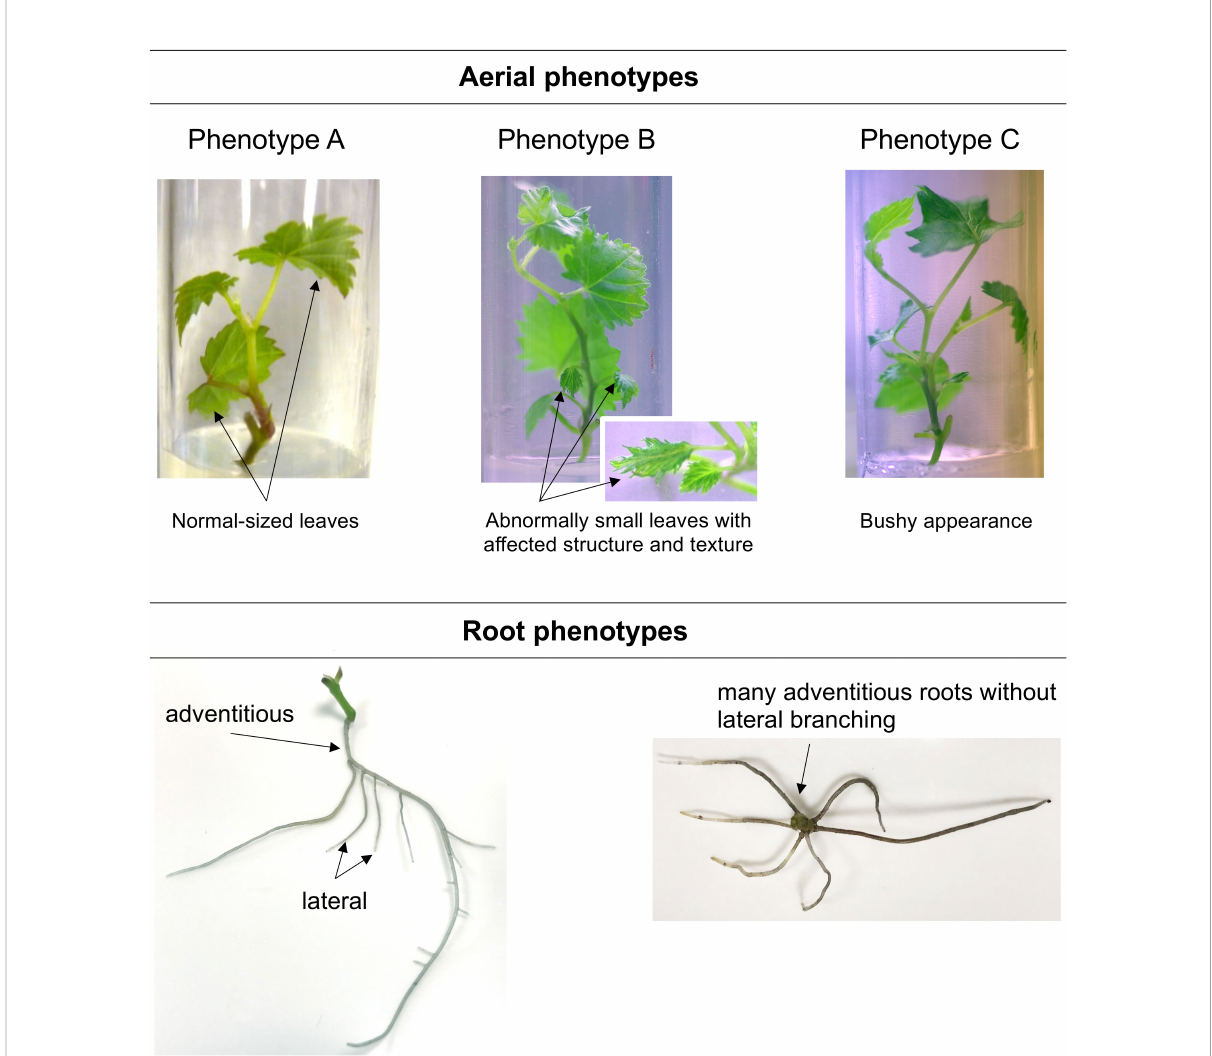
FIGURE 3 Illustration of the phenotypes observed for control and BS-treated grapevine plantlets. Micro-cuttings were transplanted in a solid culture medium supplemented with BS (0.1% v/v) or water (as control). Their phenotype was observed at 4 wpt. Three aerial phenotypes could be distinguished: shoots with normal-sized leaves (Phenotype A), shoots with the presence of abnormally small leaves (Phenotype B), shoots with bushy appearance (Phenotype C); and two root ones: branched root system with the presence of lateral roots, adventitious roots without lateral